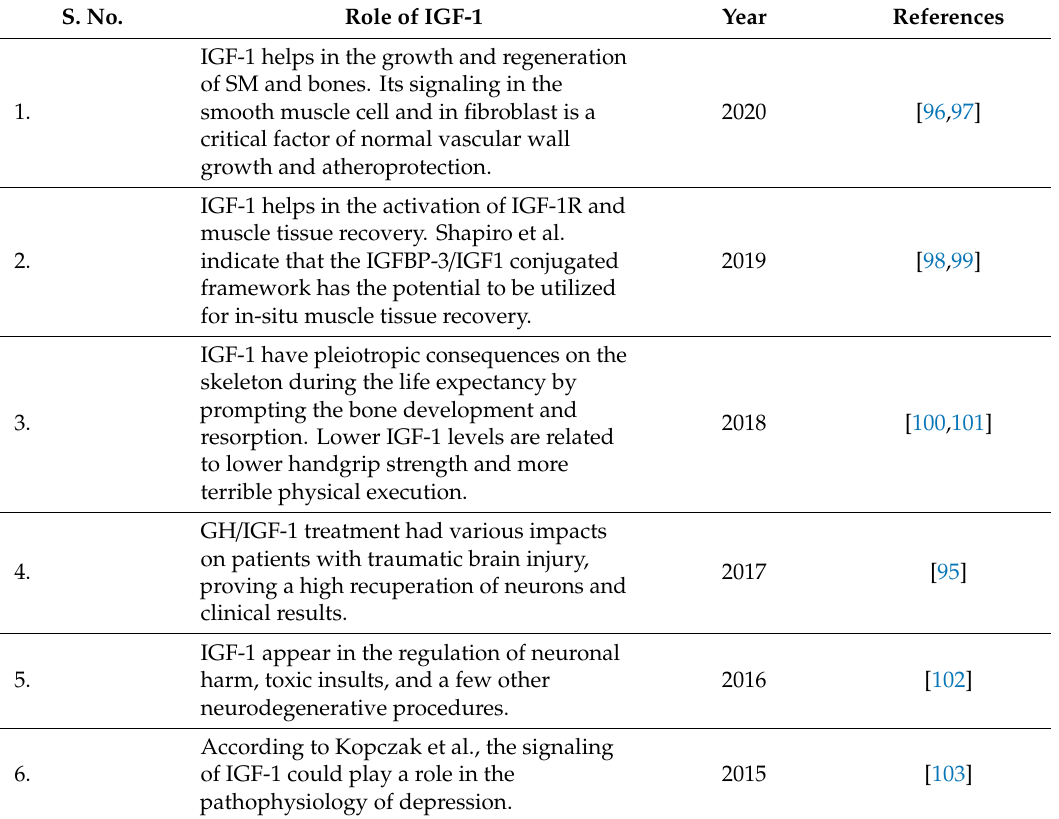
Table 1. Recent research studies on IGF-1 in di ff erent